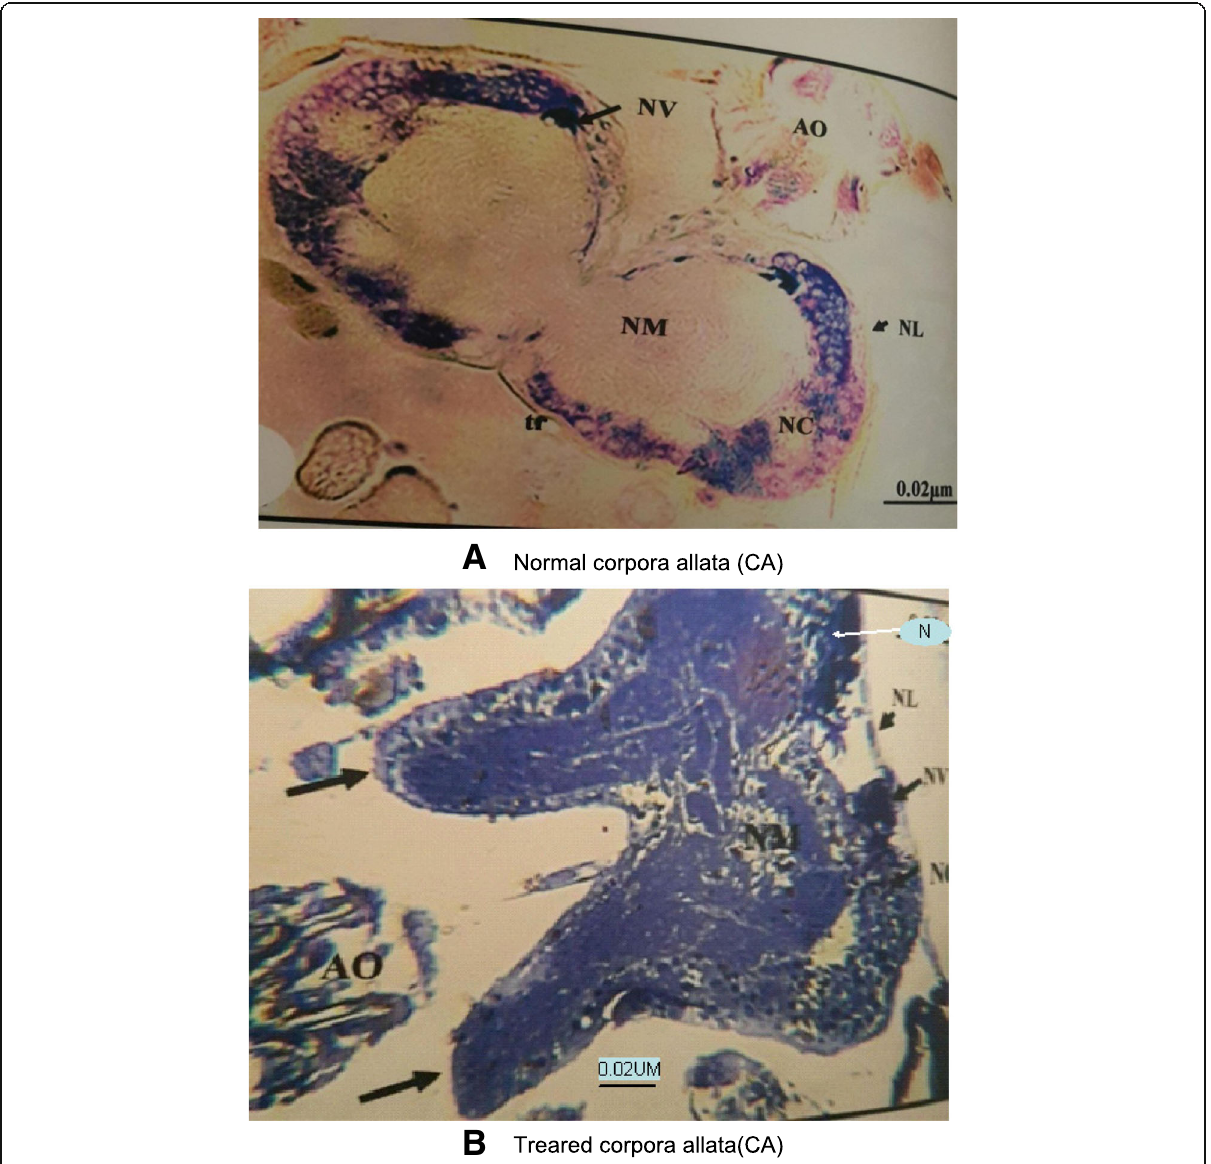
medial cerebral, NV nerve, CC corpora cardiac, NC nerve cells, NL neural lamella, D dendrites, HS droplets of secretion, SG salivary gland, HSD hormone secretion droplets, NM neuropile mass, CA corpus allatum, AO aorta, Tr tracheoles, Pg prothoracic gland, C cell body, M membrane, BM basal